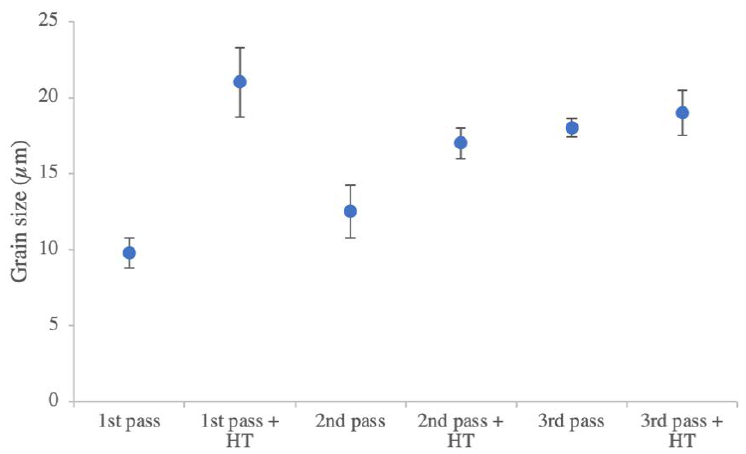
Figure 17. Graph showing the change in the grain size of the cold-drawn CP-Ti Gr 2 wire through each of the three drawing passes with intermediate annealing heat treatments (HT).